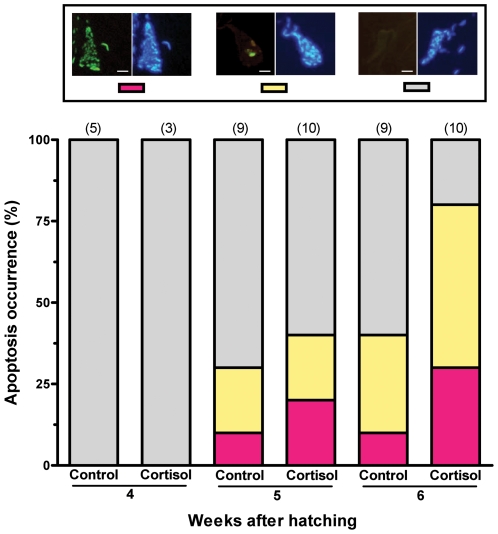
Incidence of gonadal apoptosis (TUNEL assay) in cortisol-treated (0.8 mg/g food) larvae between 4 and 6 wah.Apoptosis occurrence is defined as the percentage of individuals showing each of the categories of apoptosis indicated in the left side of the top panels (red: abundant, yellow: few, grey: none; the right side shows DAPI nuclear staining for visualization of cells). Scale bars represent 10 µm; numbers within parenthesis indicate sample number. Cortisol-treated larvae showed markedly higher incidence of gonadal apoptosis compared to control larvae at 6 wah.